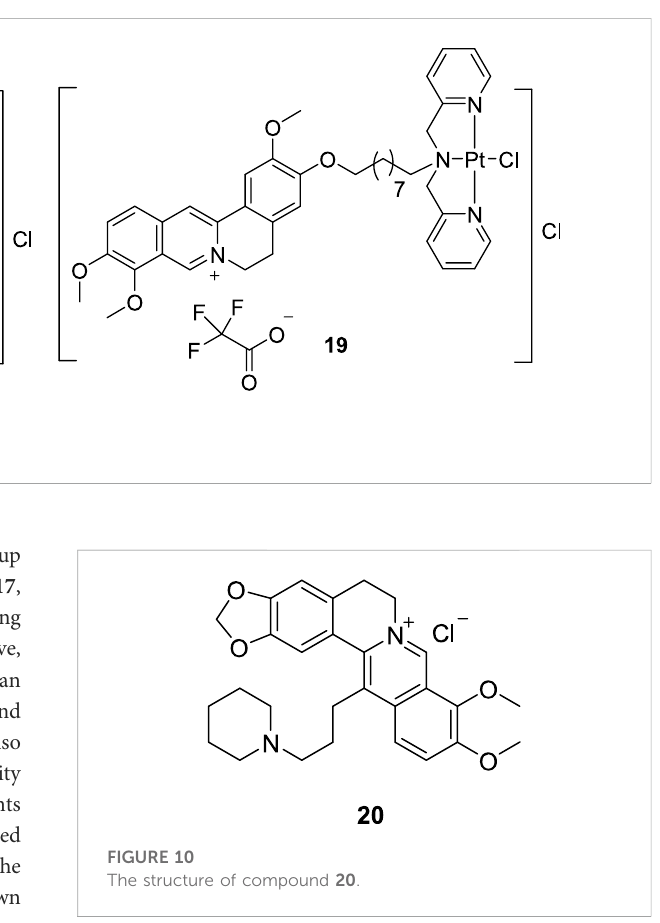
FIGURE 10 The structure of compound 20